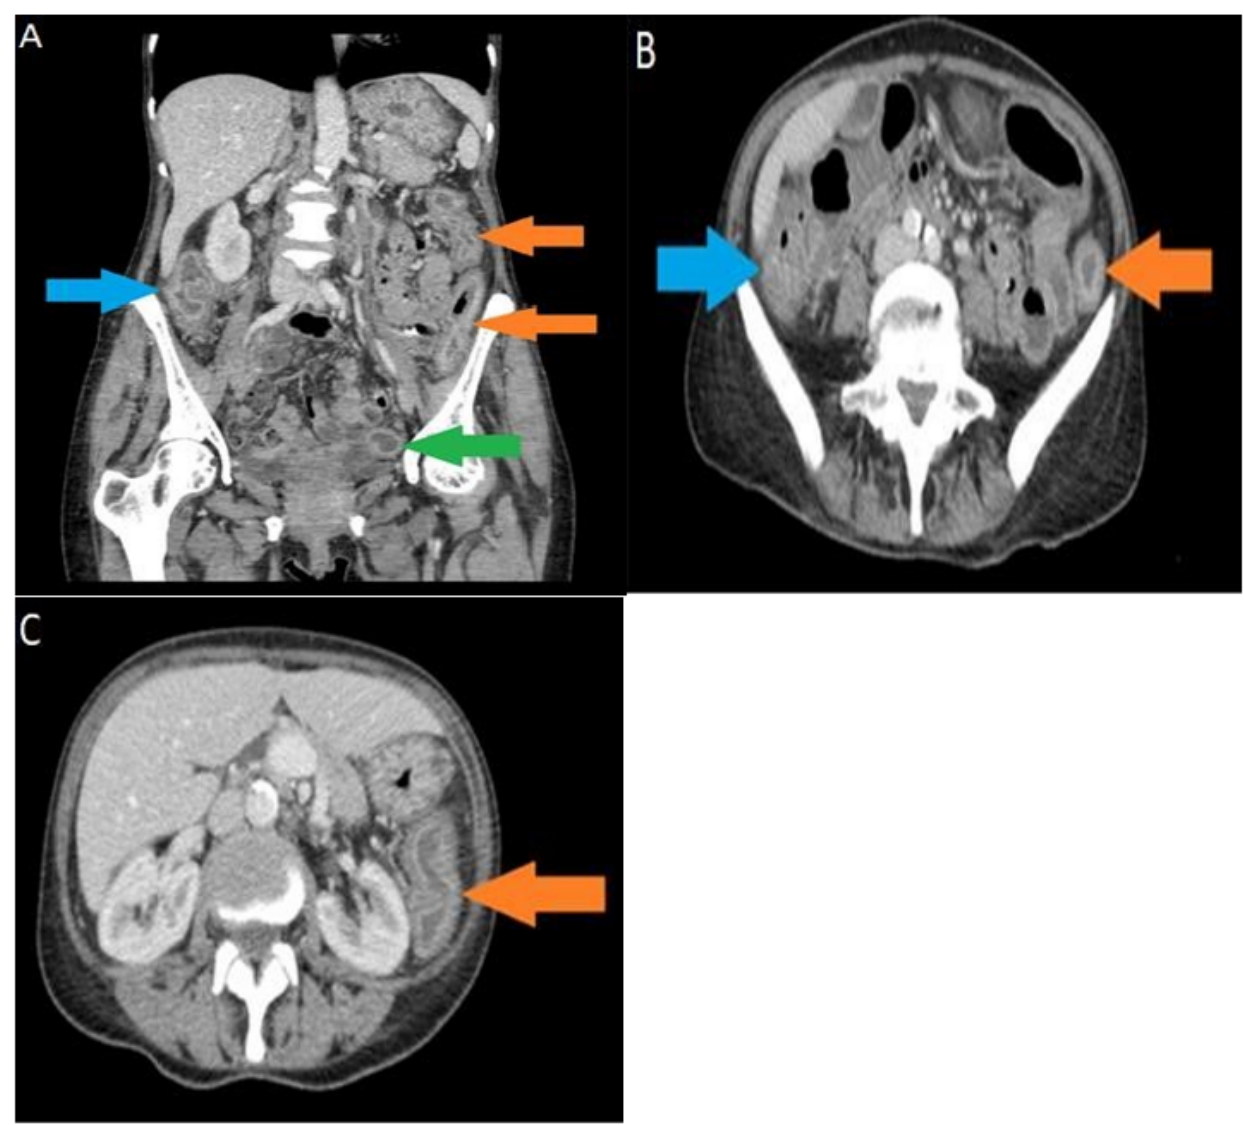
Figure 1. ( A ) Selected coronal CT image, acquired in the portal venous phase, shows marked bowel wall thickening and mucosal hyperenhancement in the ascending colon (blue arrow), descending colon (orange arrows), and sigmoid colon (green arrow), in agreement with the diagnosis of active multifocal colitis; ( B ) selected axial CT image, acquired in the portal venous phase, shows marked bowel wall thickening and mucosal hyperenhancement in the hepatic flexure of the large bowel (blue arrow) and splenic flexure of the large bowel (orange arrow), in agreement with the diagnosis of active multifocal colitis; ( C ) selected axial CT image, acquired in the portal venous phase, shows marked bowel wall thickening and mucosal hyperenhancement in the descending colon (orange arrow), in agreement with the diagnosis of active colitis.